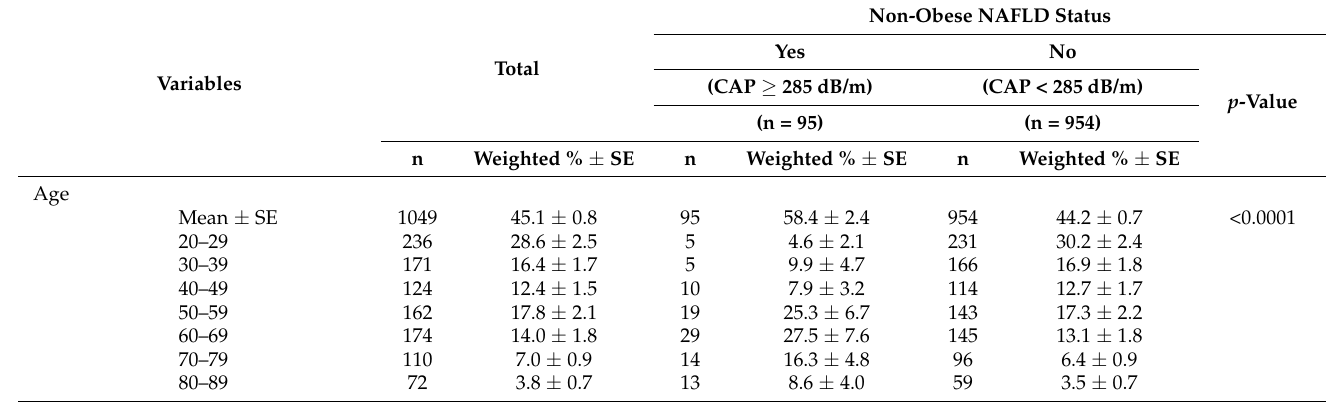
Table 1. Characteristics of factors according to non-obese NAFLD status by